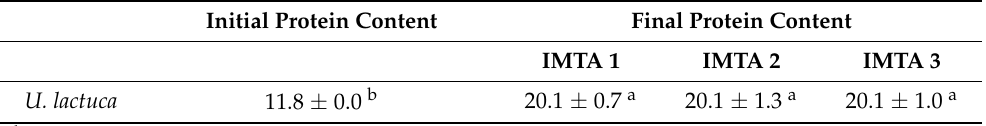
Table 5. Initial and final protein concentration (% of dry weight) (mean ± standard deviation) of U. lactuca in the IMTA 1 (with 1 g Ulva L − 1 ), IMTA 2 (2 g Ulva L − 1 ), and IMTA 3 (3 g Ulva L − 1 ) treatment groups during the 35 days of